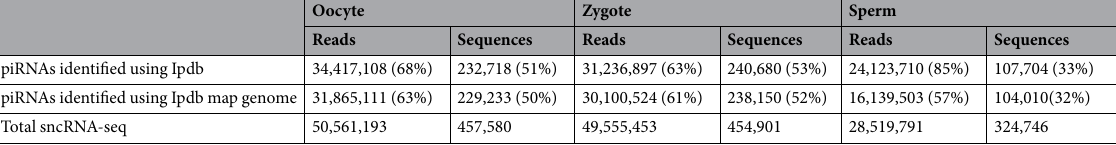
Table 1. piRNA identification statistics using the piRNA IP database. Percentages in brackets were calculated in relation to total number of sequences present in the sncRNA